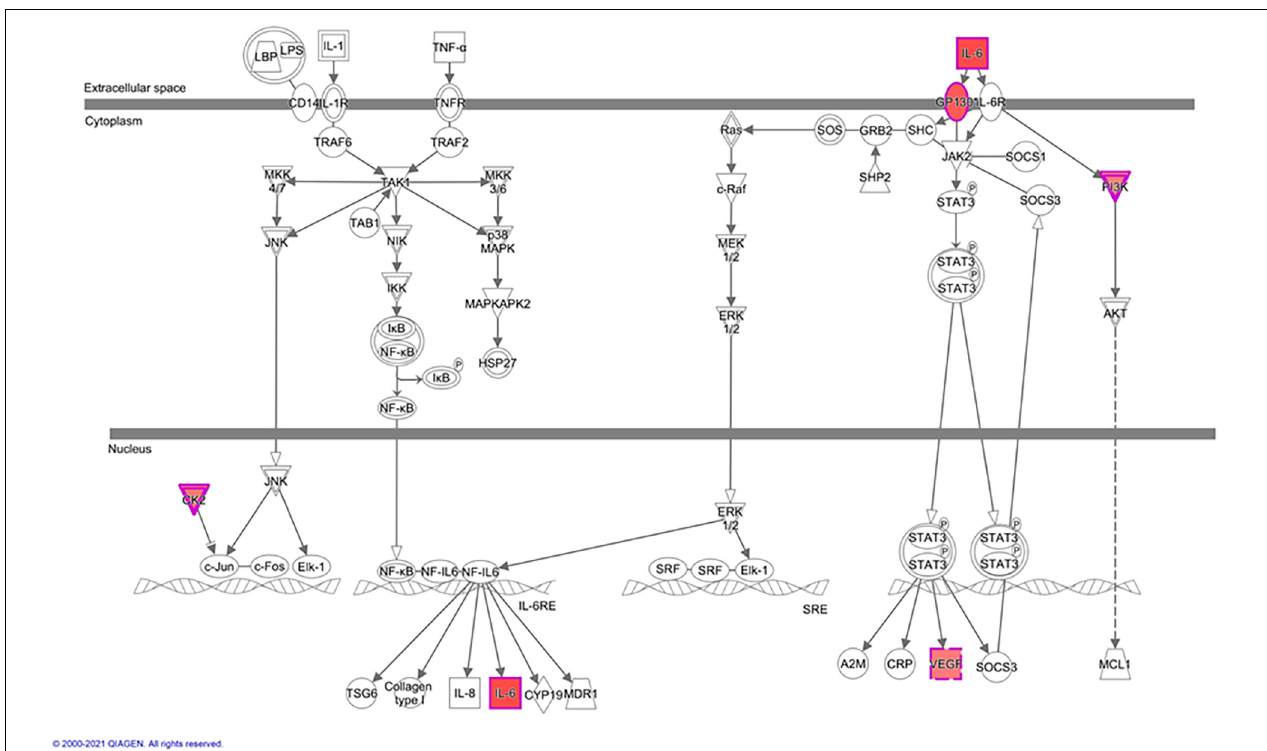
FIGURE 4 | Rictor silencing up regulated components of IL-6 signaling in PHT cells. Graphical representation of PHT cell IL-6 signaling networks identified by Ingenuity Pathway Analysis (IPA) following rictor silencing. Molecular relationships between genes up-regulated (red) or no change (white) in expression after rictor silencing are shown; CSNK2A1, Casein kinase 2 alpha 1; IL6, Interleukin 6; IL6ST, Interleukin 6 signal transducer; PIK3R1, Phosphoinositide-3-kinase regulatory subunit 1; VEGFA, Vascular endothelial growth factor